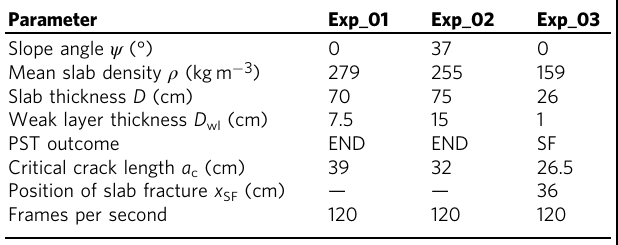
Table 1 Parameters obtained in the experiments